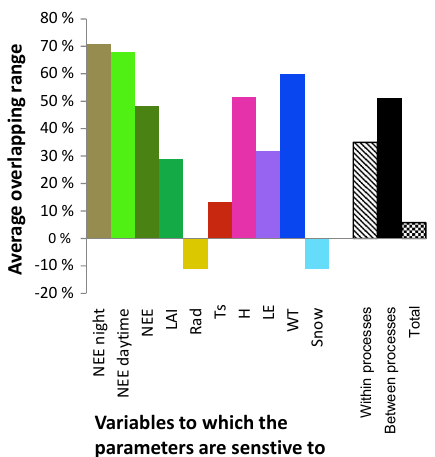
Figure 3. Connections between processes and parameters of differ- ent process categories. The y axis shows the count of parameters from the different process categories (colours) that are sensitive to model performance in the various variables ( x axis).